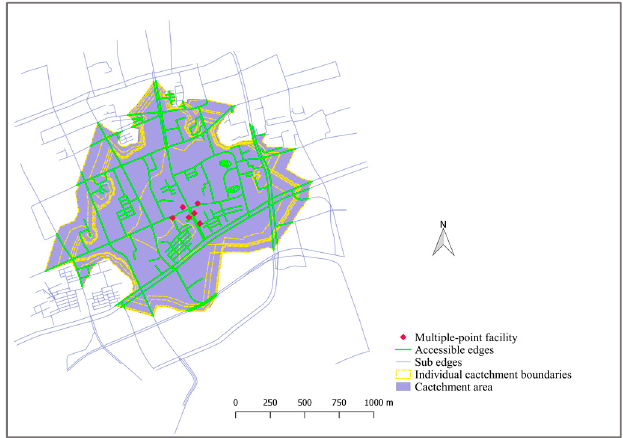
Figure 10. The catchment area of a multiple-point facility based on an undirected road network.